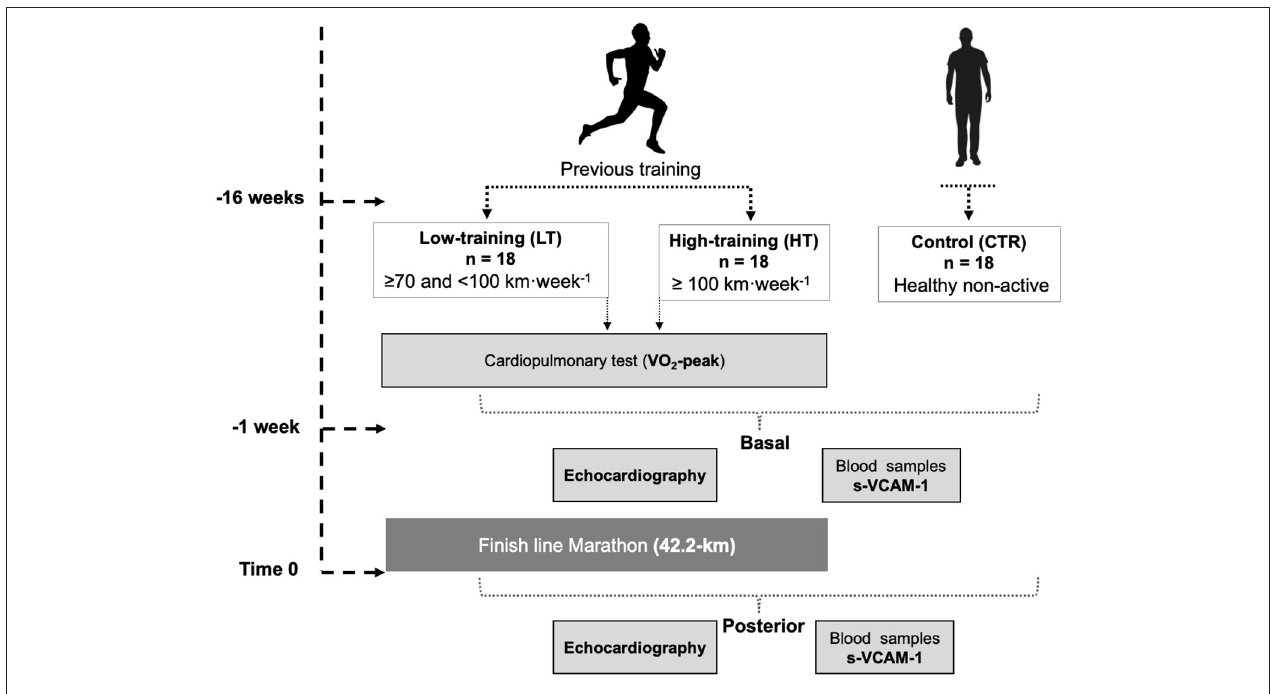
FIGURE 1 | Study scheme